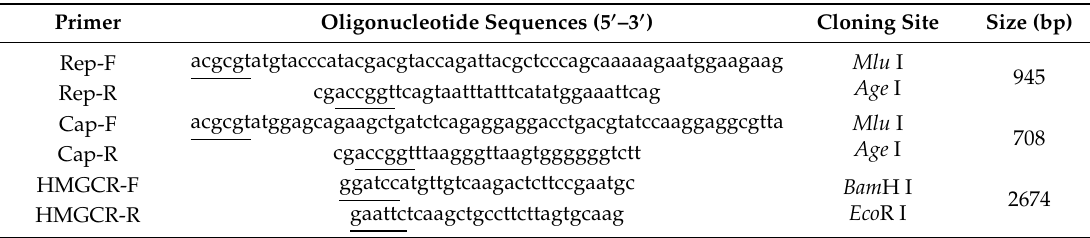
Table 1. Primers used in this